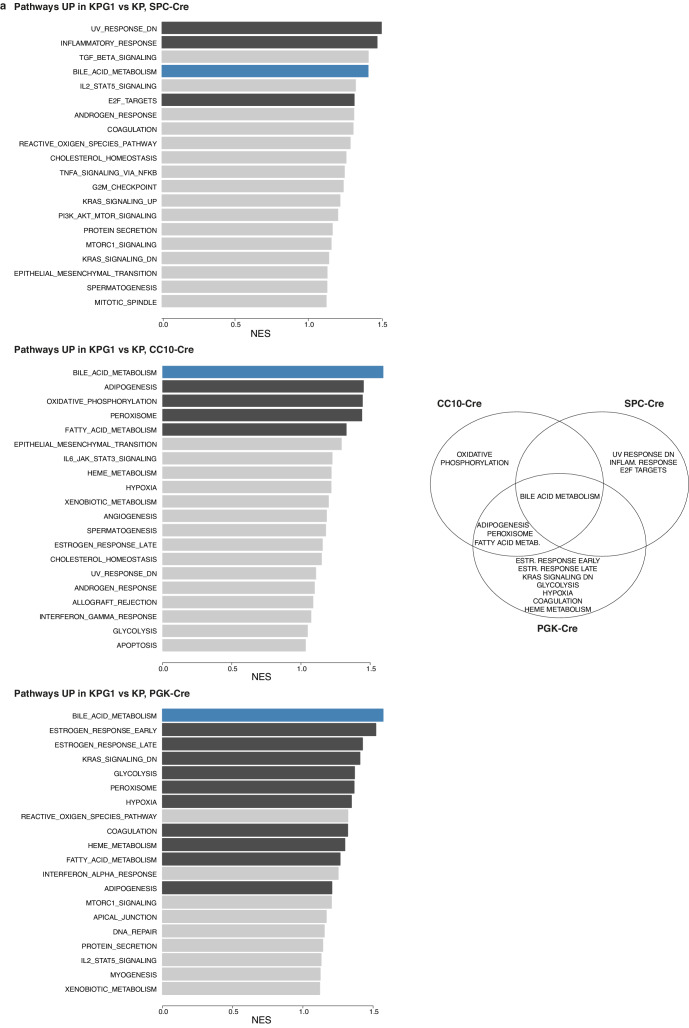
Hallmark ‘bile acid metabolism’ is upregulated in Glut1-deficient tumors.(a) (left panels) Top 20 Hallmark pathways enriched in genes induced in KPG1 versus KP in SPC-Cre (top left), CC10-Cre (middle left) and PGK-Cre (bottom left). Bar length shows the normalized enrichment score obtained by Gene Set Enrichment Analysis (GSEA). Genesets with significant enrichment (p-value < 0.05) are shown in dark gray. Bile acid metabolism pathway is highlighted in blue. (right panel) Venn diagram showing induced pathways shared between SPC-Cre, CC10-Cre and PGK-Cre tumors in KPG1 compared to KP tumors.